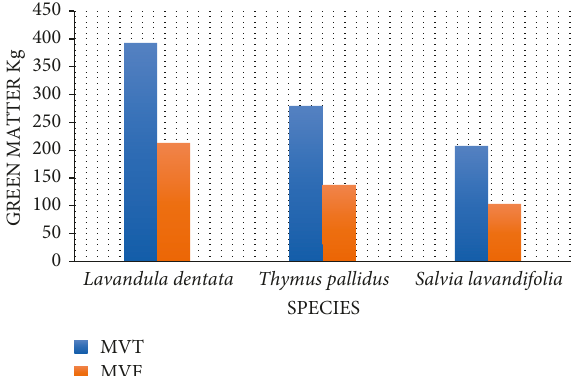
Figure 8: Average total green mass (MVT) and leaf green mass (MVF) curve per hectare in the Bigoudine